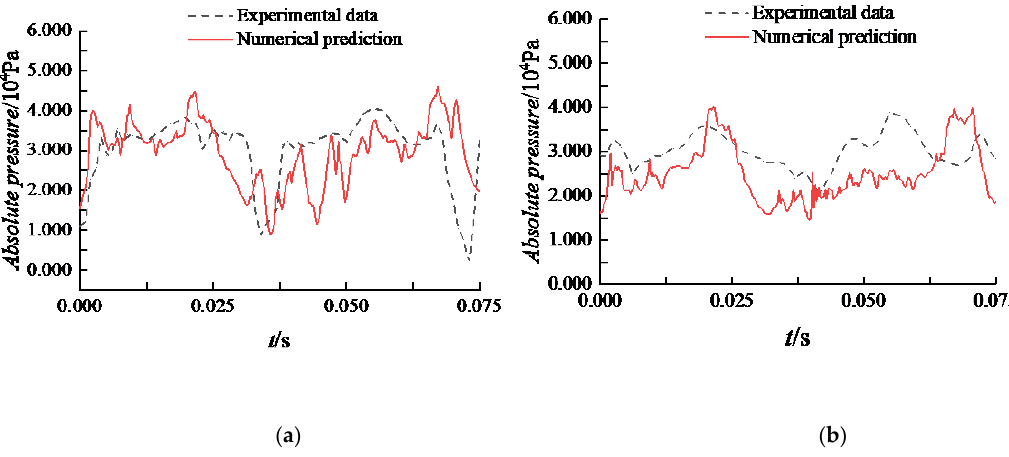
Figure 6. Comparison of pressure fluctuations on the surface of the model at P2 ( a ) and P4 ( b ).